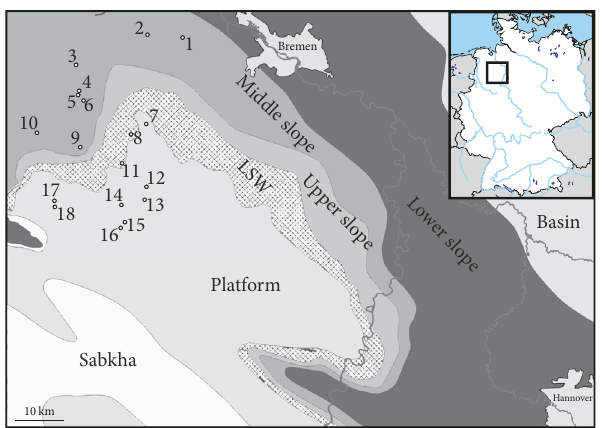
Figure 3: Paleogeography of the Zechstein-2-Carbonate for the study area in northern Germany. The map displays the studied wells and the uppermost facies association of the Stassfurt Carbonate (Ca2) within this area (modified after Strohmenger and Strauss